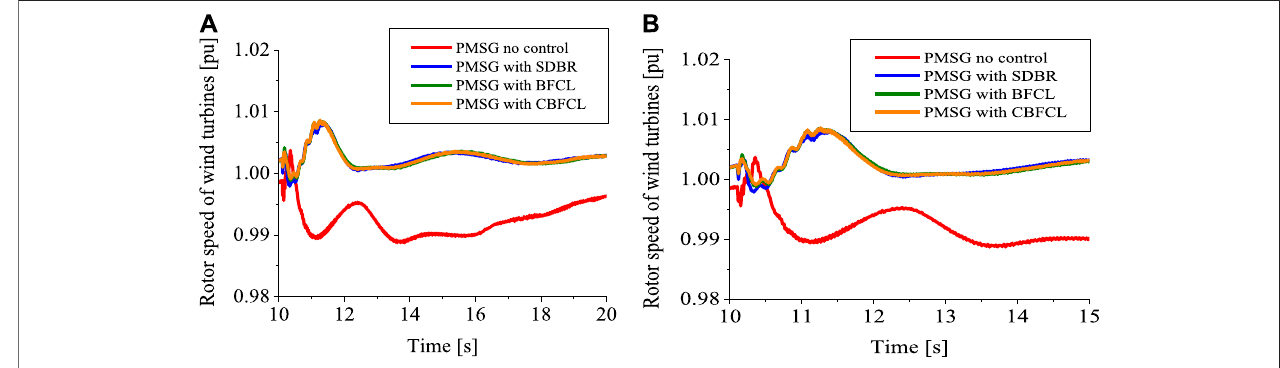
FIGURE 12 | (A) Rotor speed of the PMSG wind turbine. (B) Zoom of Figure 12A .